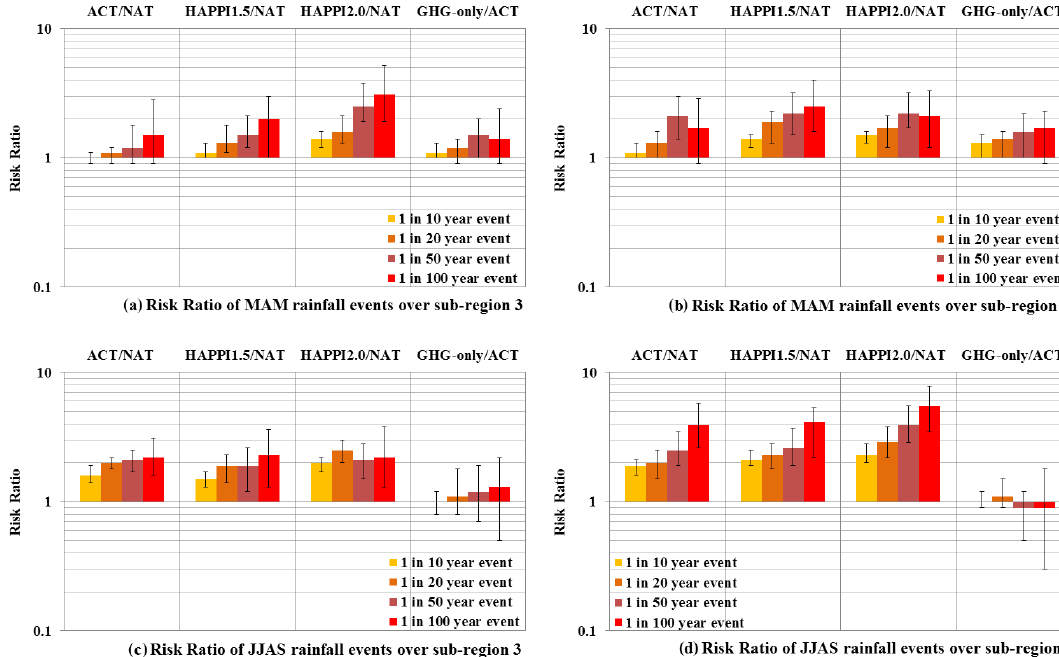
Figure 11. Same as Fig. 10, but for MAM and JJAS risk ratios over the two southern sub-regions 3 and 4.